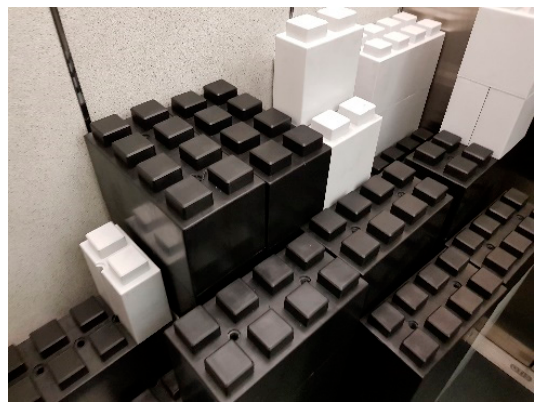
Figure 4. Everblocks unboxed and awaiting assembly in the living